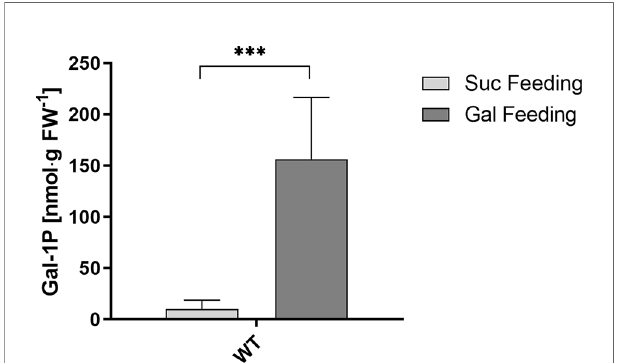
FIGURE 6 | Gal-1P concentrations in root samples of WT seedlings. GC – MS measurements of Gal-1P levels in plants under Gal-feeding (5 mM Gal) versus Suc-feeding (5 mM Suc) conditions. Mean values (± SD) of three biological replicates with three technical replicates each are shown. Data analysis was performed using unpaired t-test ***: p